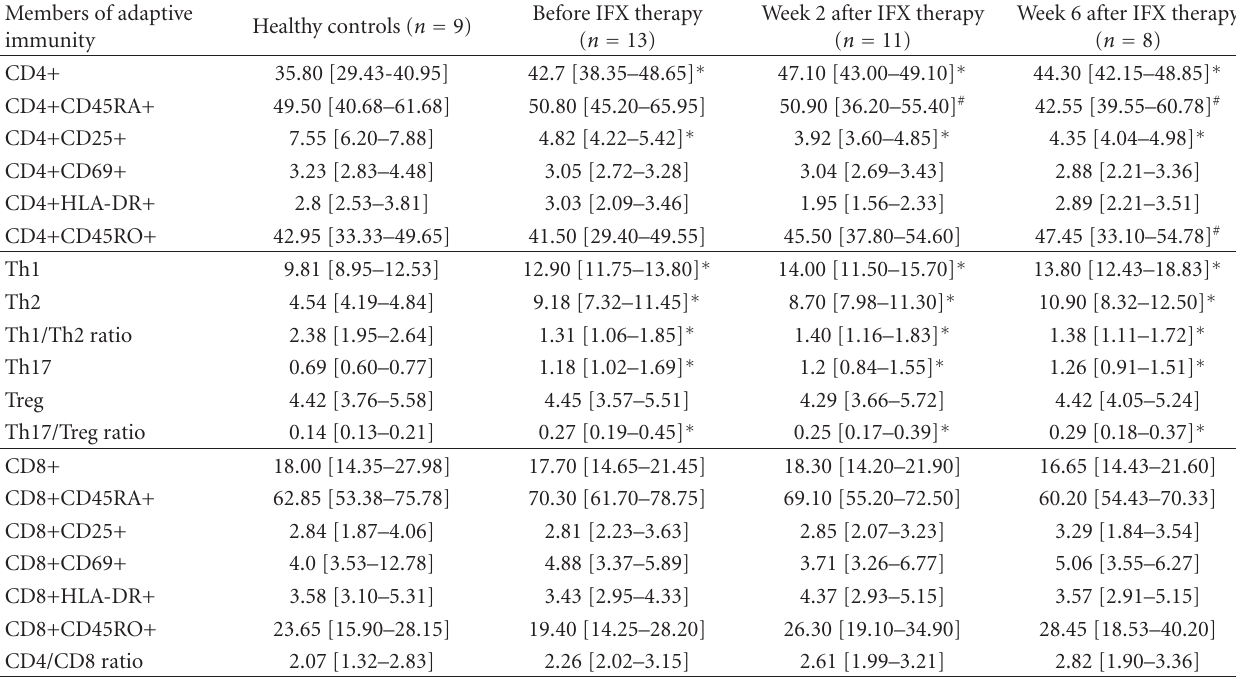
Table 1: Prevalence and ratios of T-cell subsets in ankylosing spondylitis patients before and during infliximab (IFX) therapy. Members of